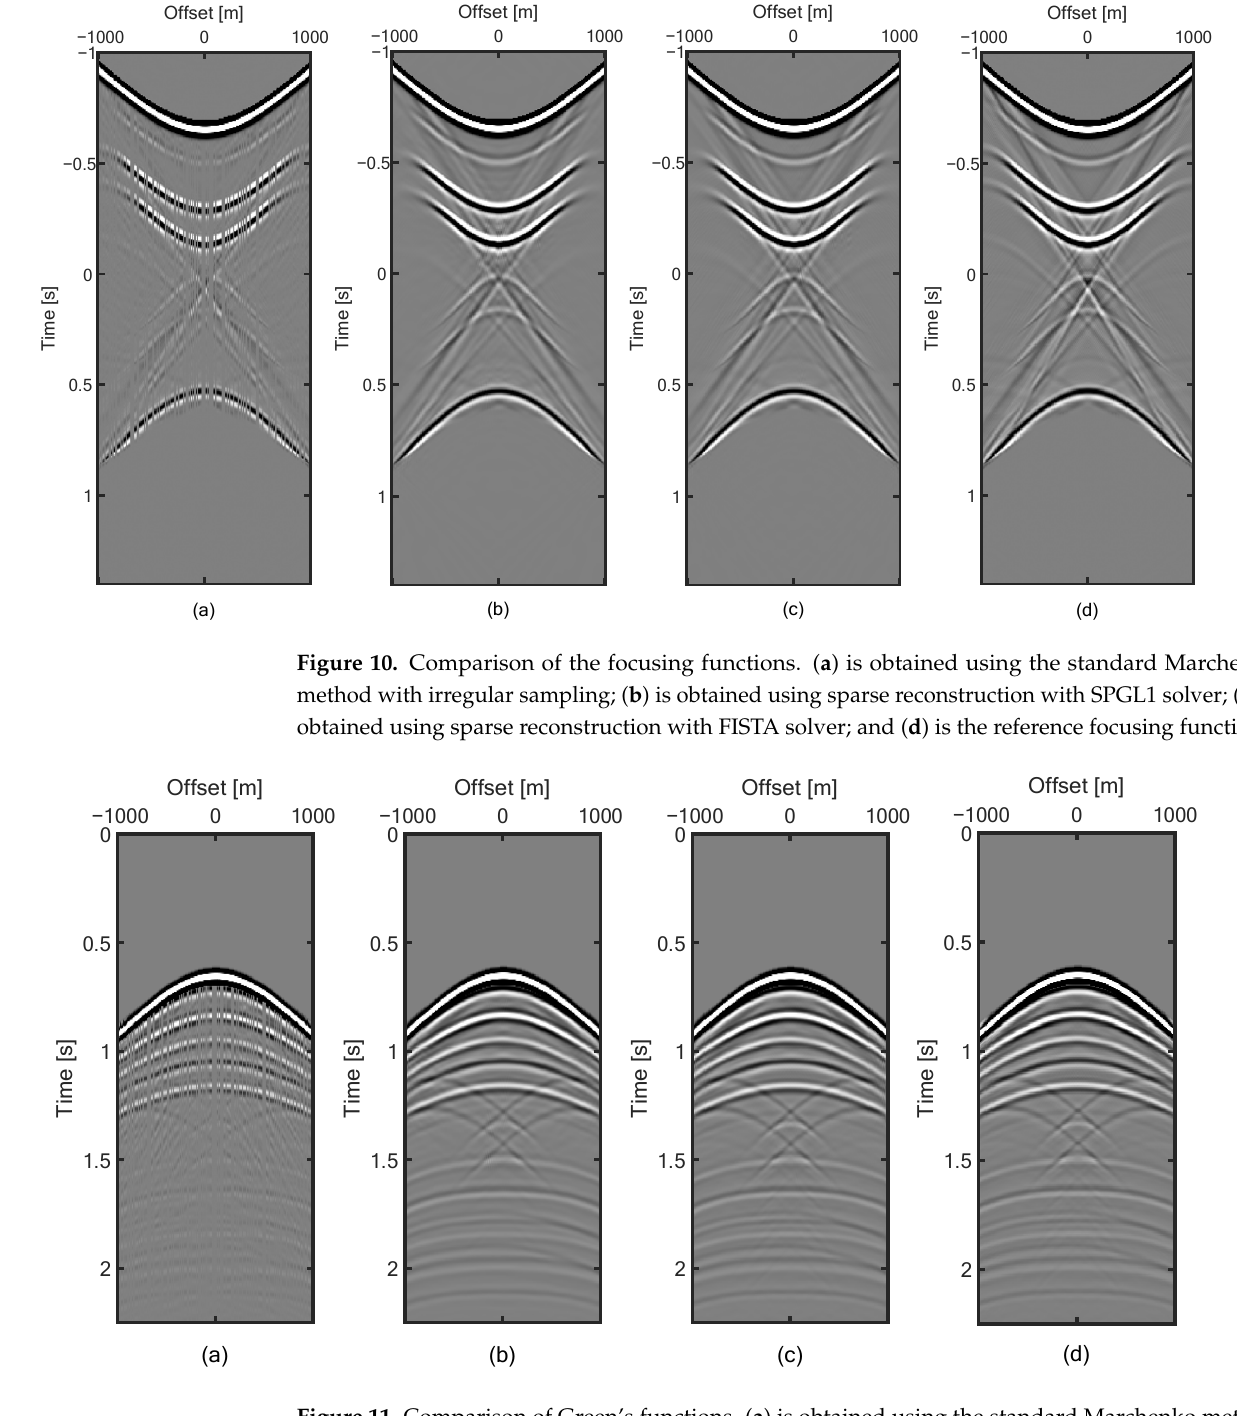
Figure 9. Comparison of convergence of the SPGL1 solver (yellow line) and the FISTA solver (purple line) in curvelet transform for focusing function reconstruction.